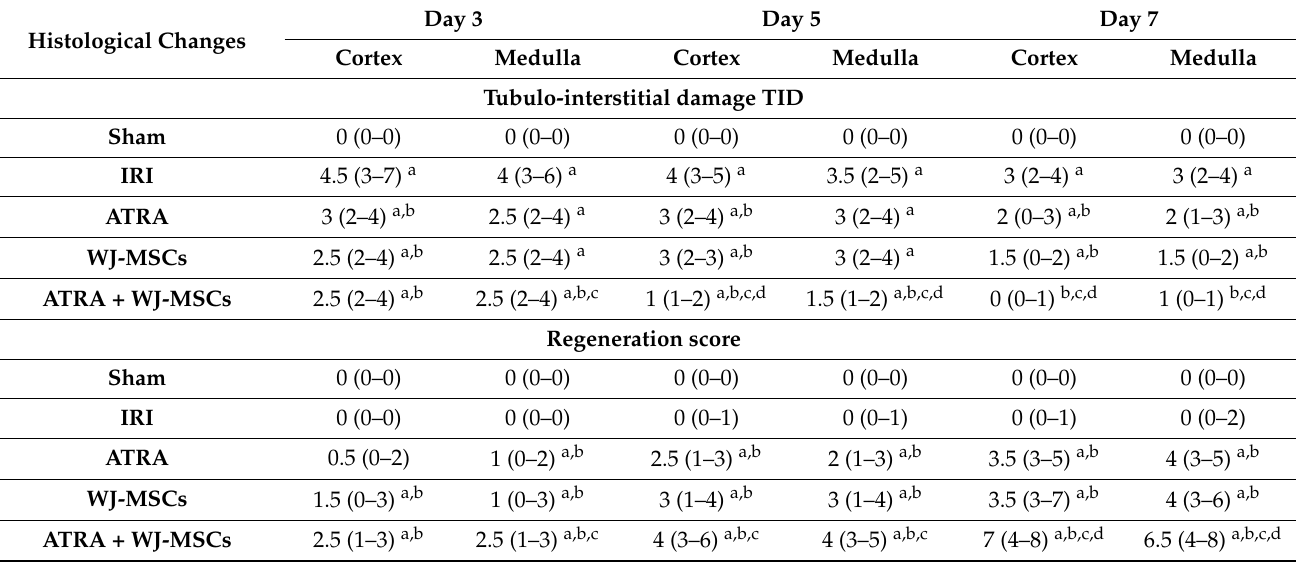
Table 3. Histopathological scores at 3 sacrifice interval time points in each group cortical and medullary histopathological changes in different groups at 3, 5 and 7 days (n =